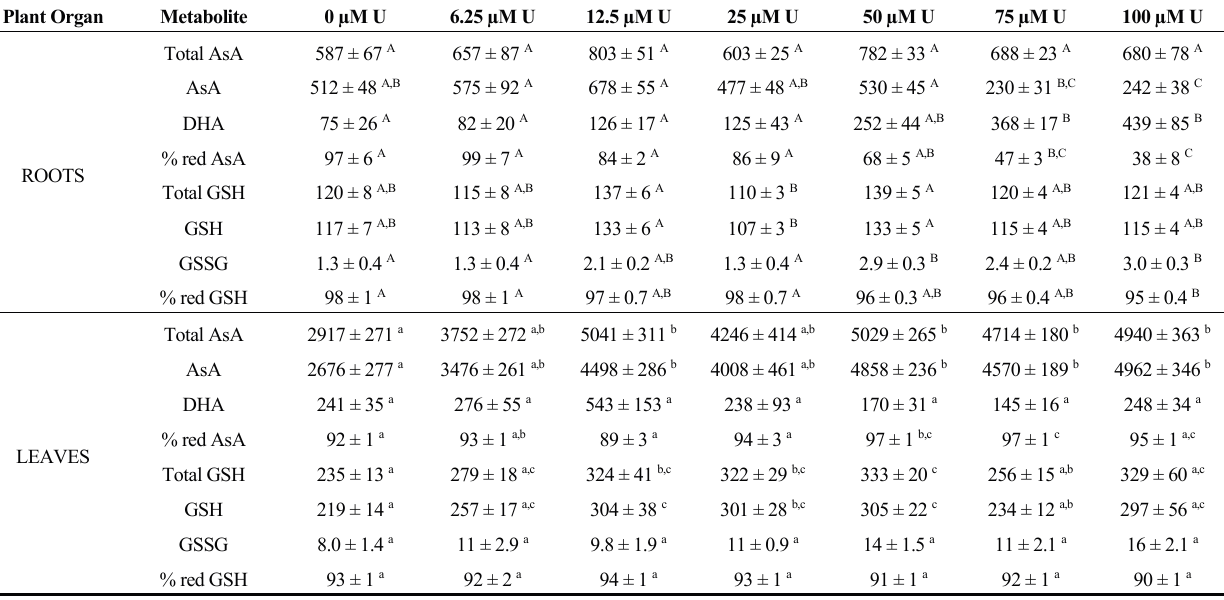
Table 1. Ascorbate and glutathione concentrations (nmol·g − 1 FW) in roots and leaves of Arabidopsis thaliana plants exposed to different U concentrations at pH 7.5 for three